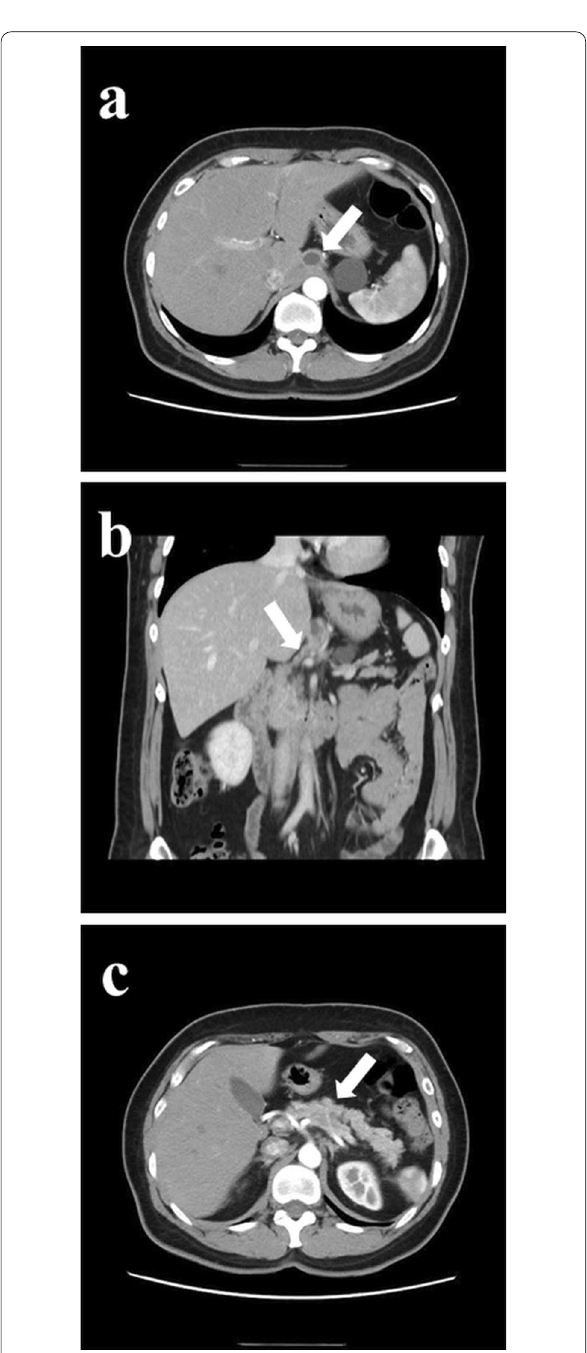
Fig. 1 CT images before neoadjuvant chemotherapy. a A cystic nodular lesion observed beside the crus (white arrow), and cystic formation of PD was observed. b The nodular lesion was the GDC and connected to the pancreas (white arrow). c A 16-mm mass with poor contrast effect on the pancreatic body was detected (white